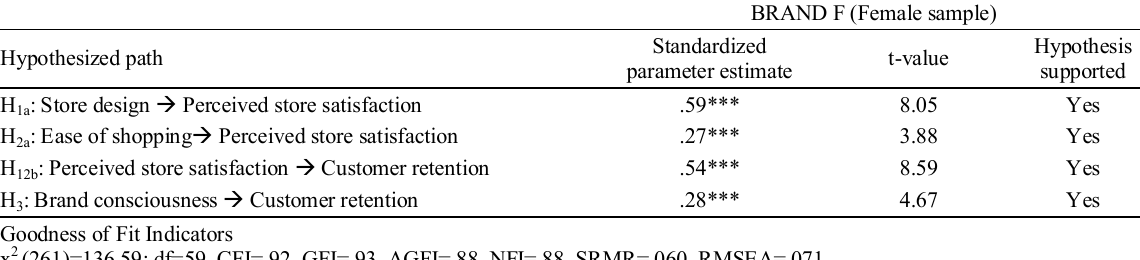
Table 3. Proposed Research Model Parameter Estimates with Significance Levels (Brand F)